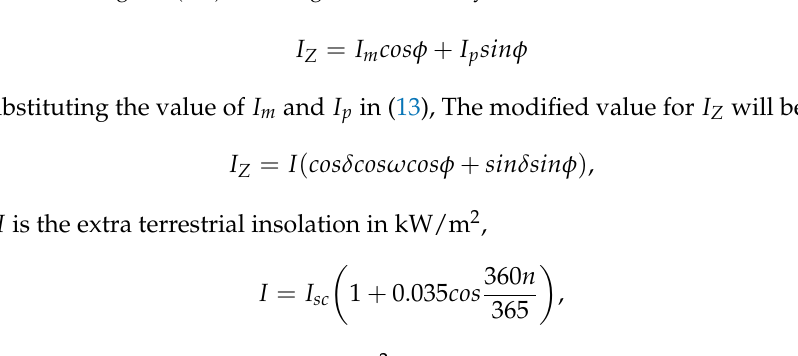
I sc is a solar constant, i.e., 1.37 kW/m 2 . At noon, ω is zero. The Hour angle to the east of noon is considered positive, and that of to the west is negative. Sunrise occurs toward the east of the meridional axis; therefore, at sunrise, the hour angle is positive, and, at sunset, it is